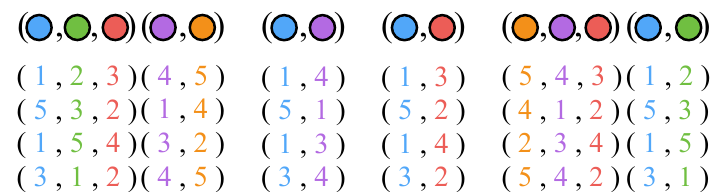
(the same featured in example (B.12b). All 5